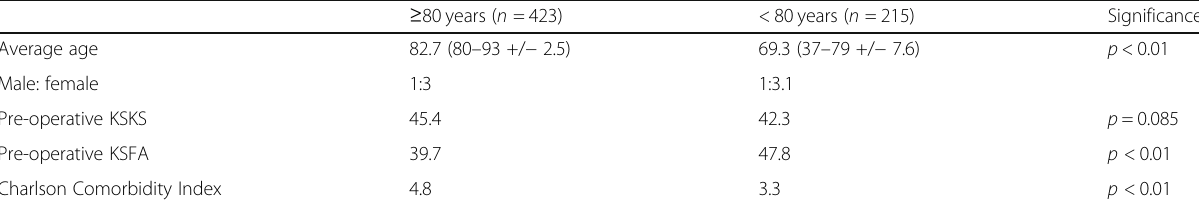
Table 1 The baseline characteristics of the elderly and control groups